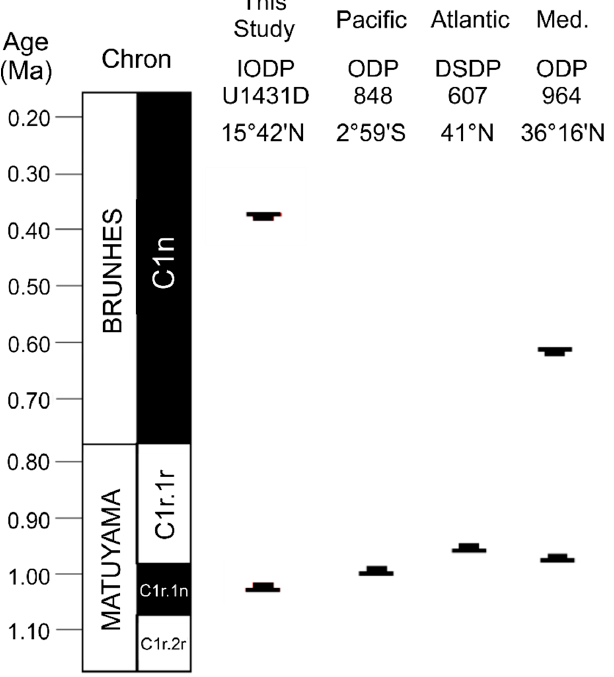
Figure 9. Comparison of stratigraphic ranges of the FO and LO of Gephyrocapsa sp. 3 from IODP/ODP/DSDP Sites. Magnetostratigraphic records from IODP Site U1431D and ODP Site 848 are calibrated to the astronomically tuned Geomagnetic Polarity Time Scale (GPTS) of [61] as compiled by [9]. Oxygen isotope data is used to determine the ages in ODP Site 964 and DSDP Site 607. These datums are calibrated to the benthic foraminiferal δ 18 O time scale of [2]. Horizontal bars represent the recalculated datum ages for each site. Upward facing horizontal bars represent FO datums, while downward facing bars signify LO datums. Med.—Mediterranean. Black—normal; white—reversed polarity.